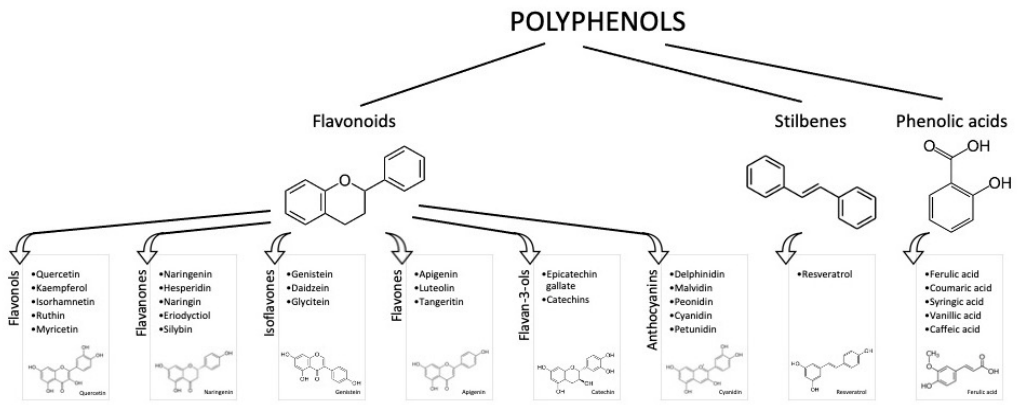
Figure 1. Polyphenol classes and chemical structures of some of their main